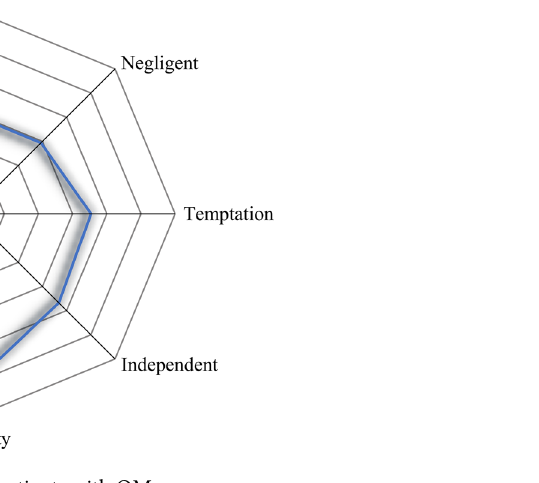
Figure 3. Chart of the TRMSs of patients with